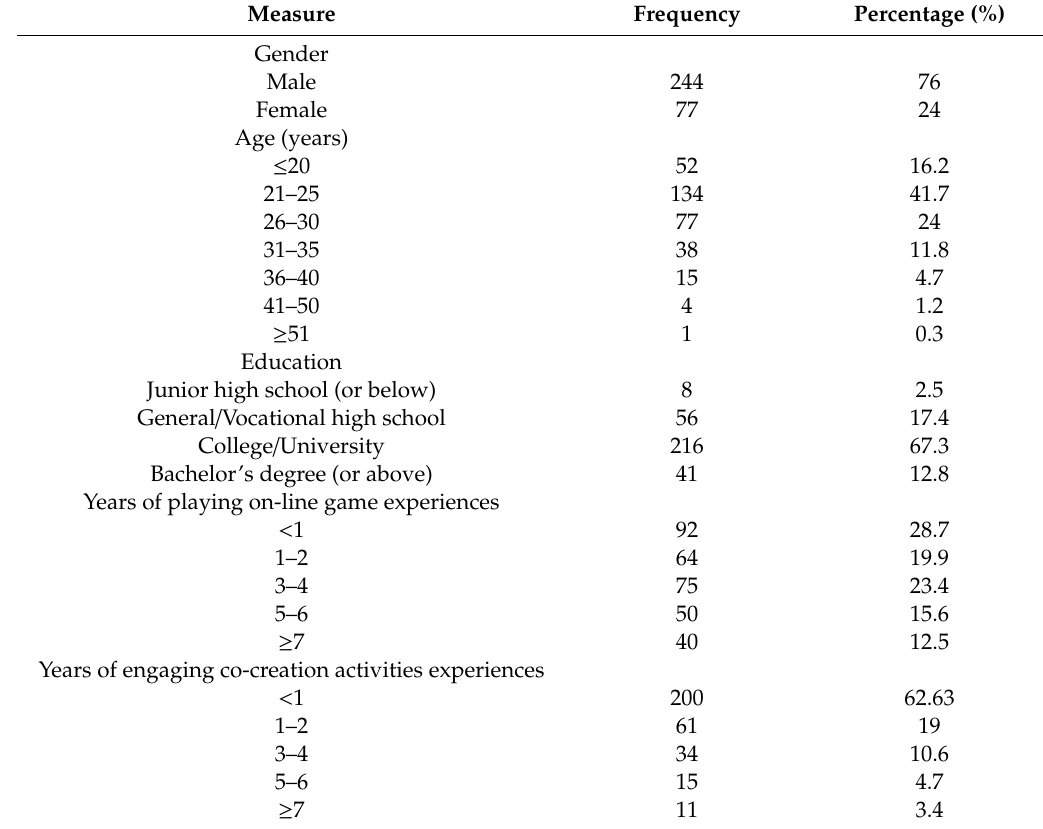
Table 1. Profile of